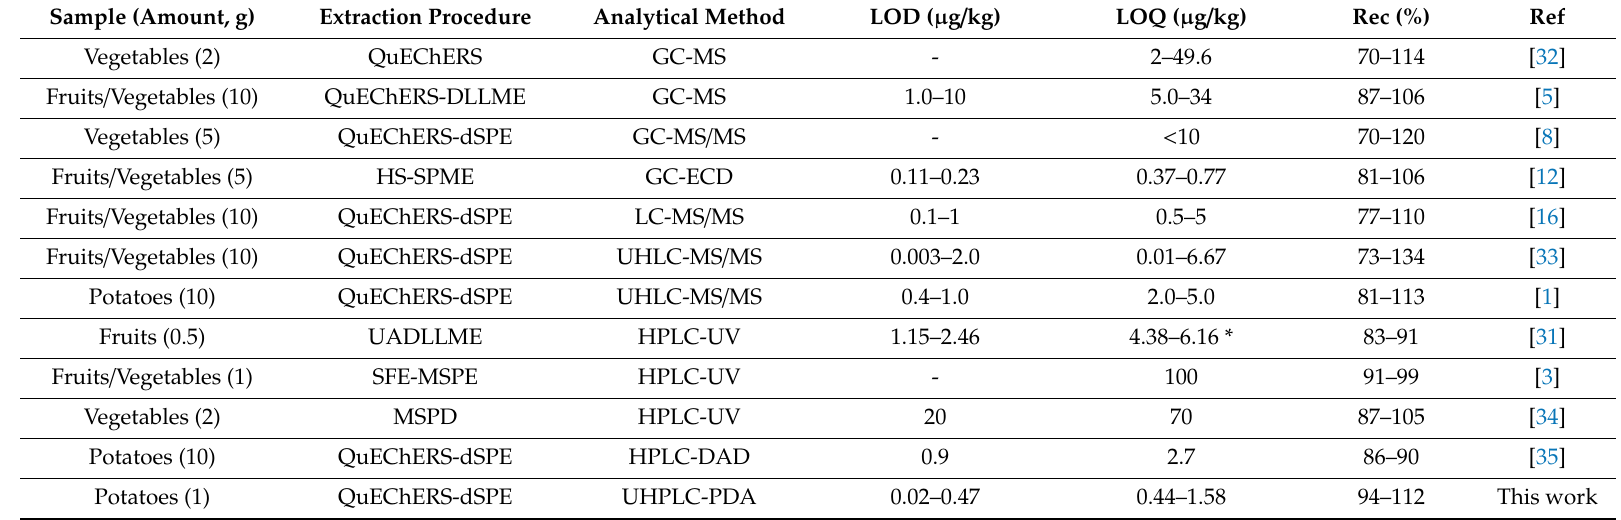
Table 4. Analytical parameter comparison of several studies carried out for pesticides quantification in